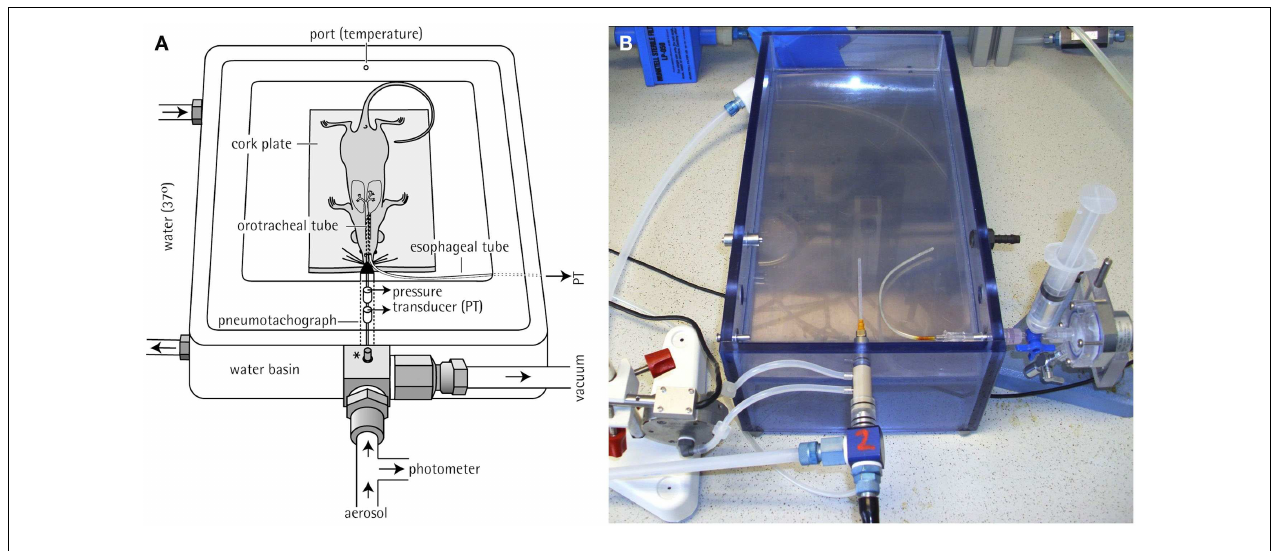
temperature. * : adaptor connected to a pressure control unit that maintains constant pressure conditions during measurements. (B) Photo of a plethysmograph unit for a rat. For the calculation of R L , P TP was recorded via an esophageal tube and tidal flow was determined by a pneumotachograph tube attached directly to the orotracheal tube.